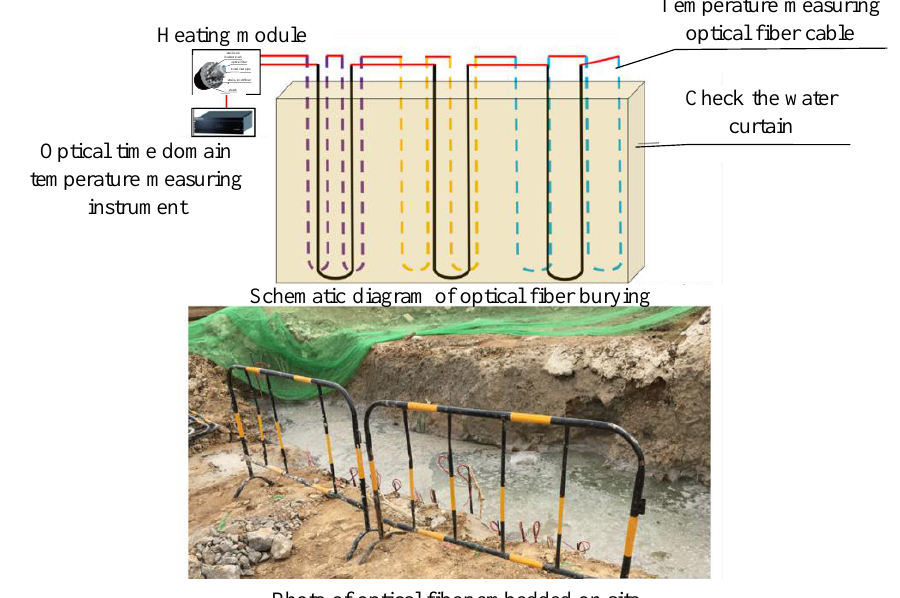
Figure 2. The layout of the fiber optic field.